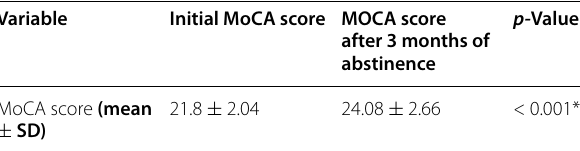
Table 4 Comparison of MoCA score in cannabis user’s baseline versus after 3 months of abstinence using paired t -test